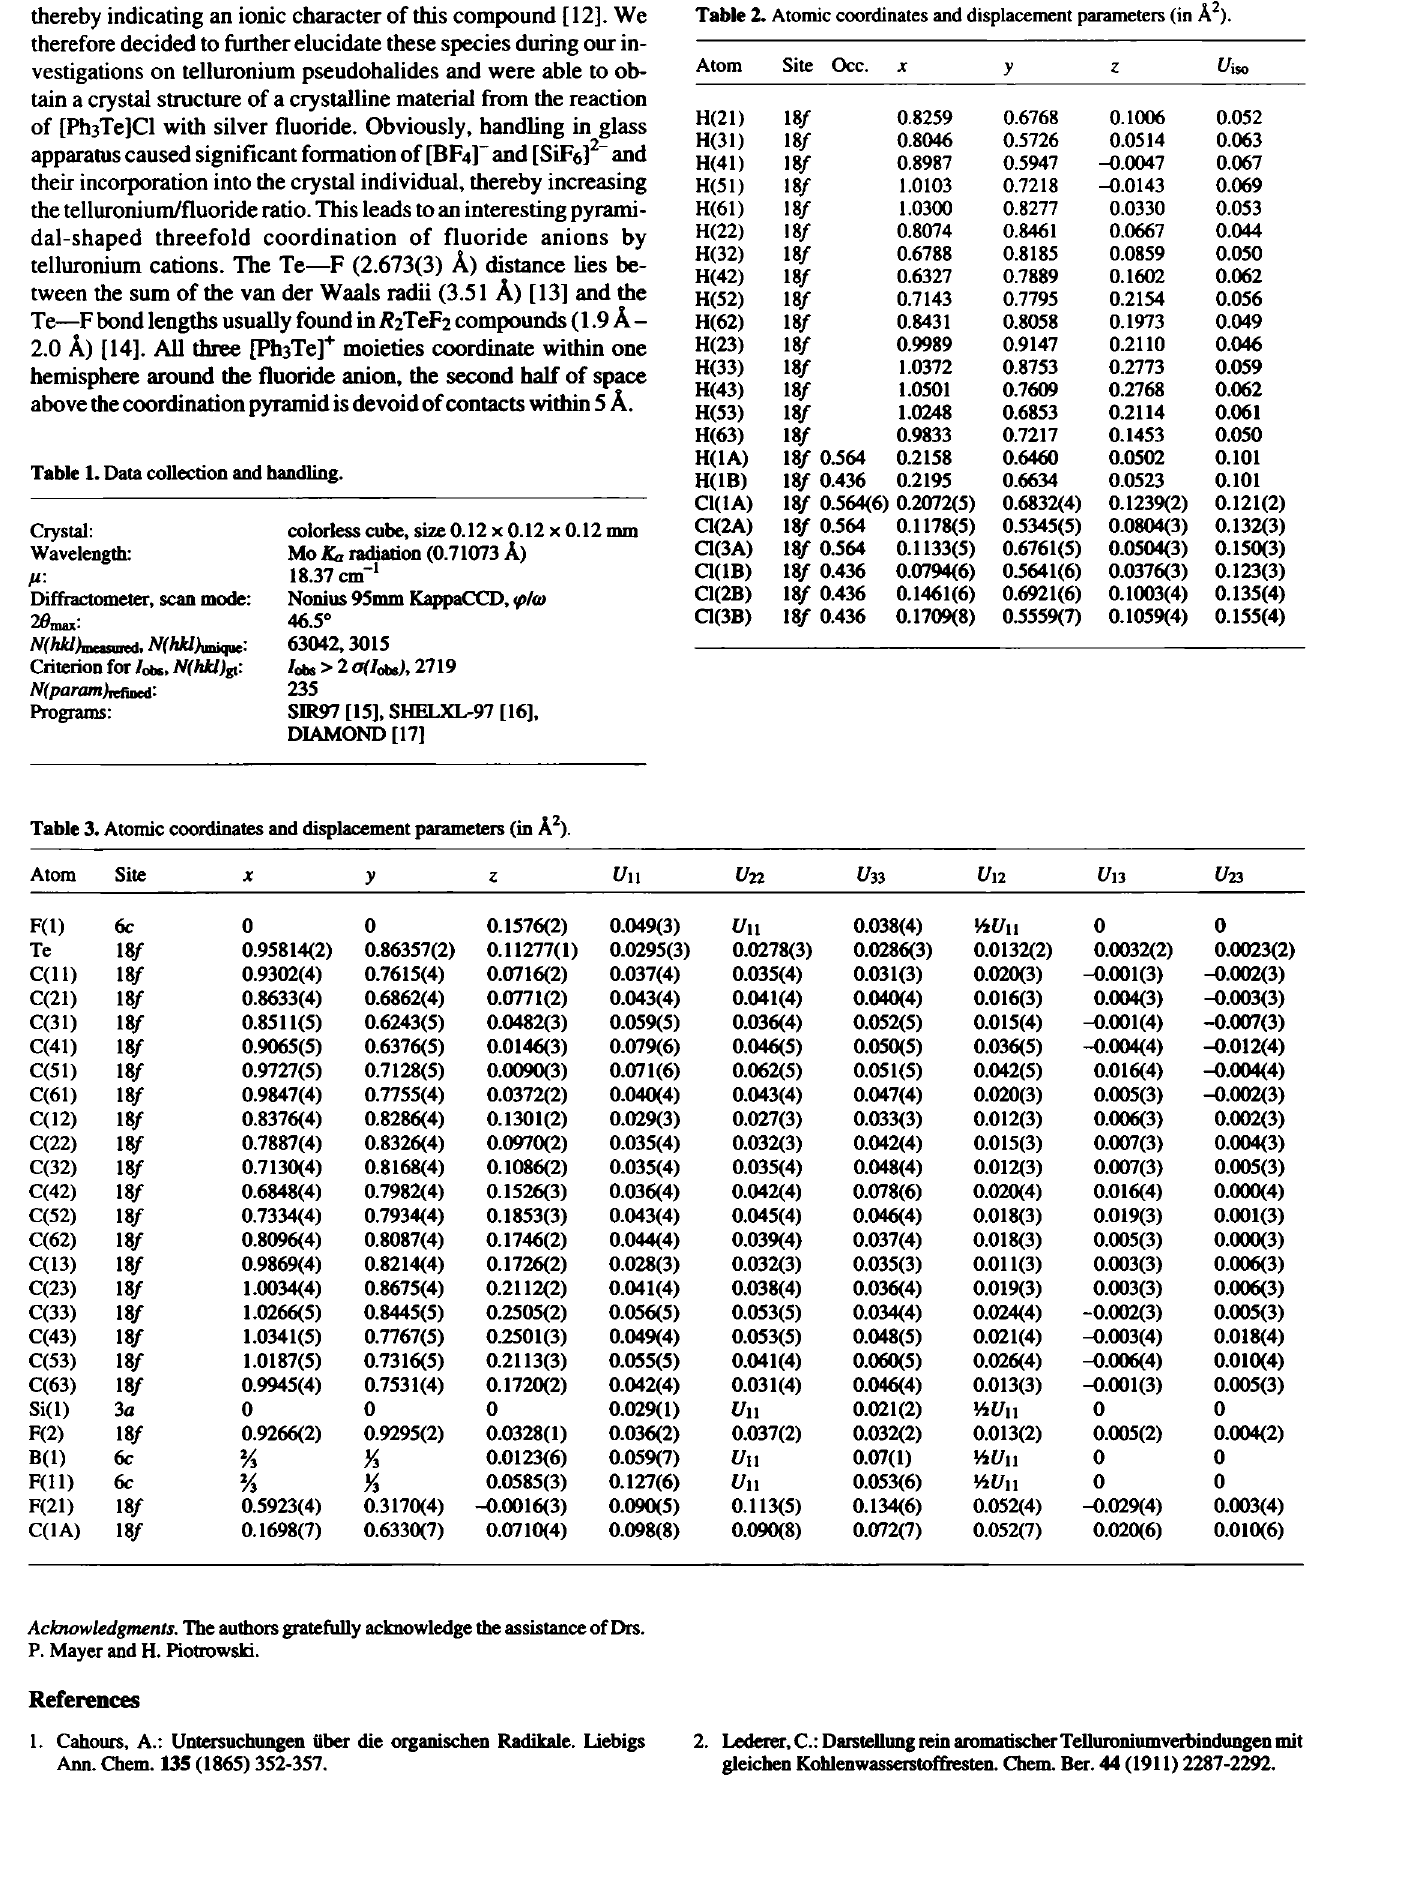
Table 2. Atomic coordinates and displacement parameters (in A 2 ).